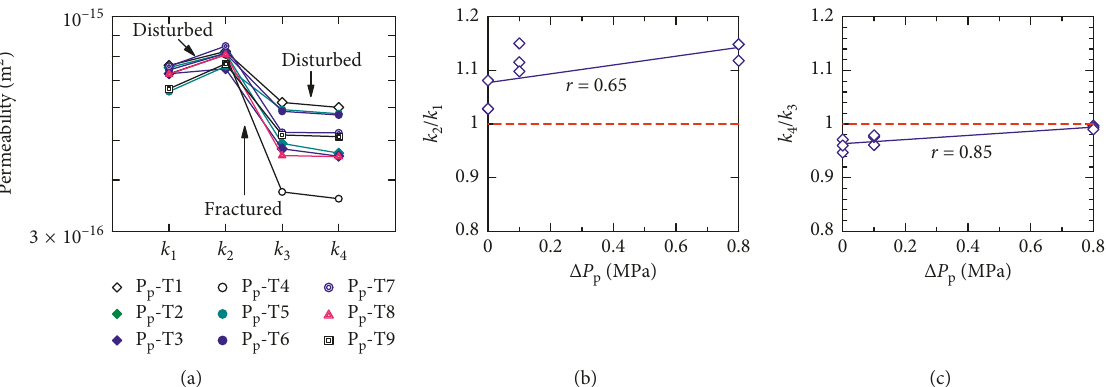
Figure 20: Variation in permeability (a), and permeability ratios of the intact rocks (b) or fractured rocks (c) ( P pore pressure disturbances and triaxial compression of the Shikotsu welded tuff.